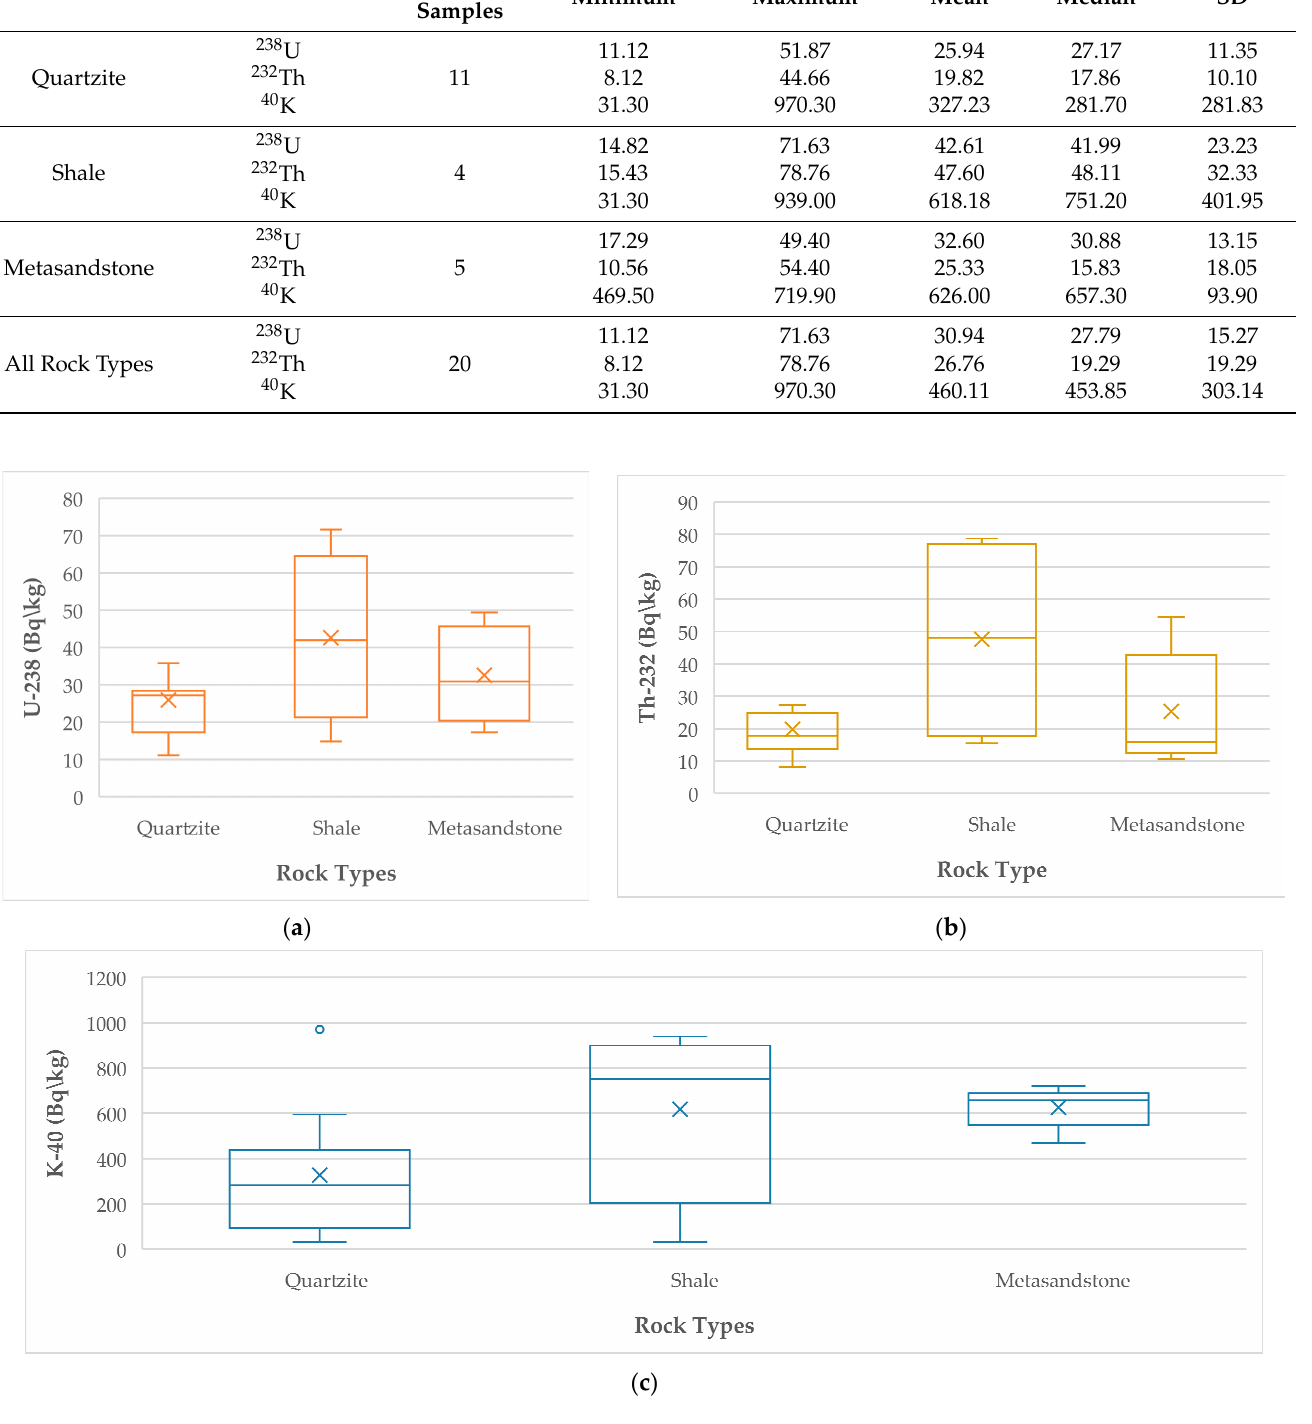
Figure 7. The activity concentration range of 238 U, 232 Th, and 40 K in the different rock types found in the West Rand and East Rand. ( a – c ) presents the concentration of 238 U, 232 Th, and 40 K in different rock types.